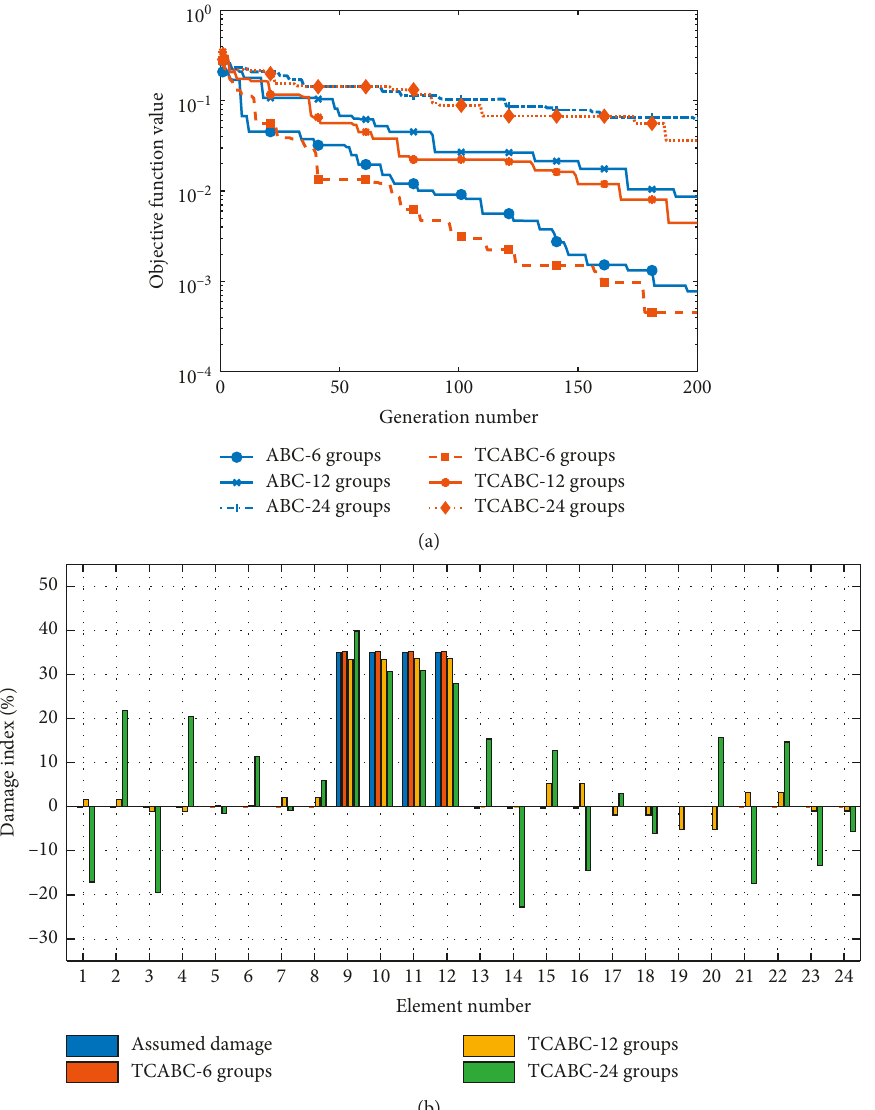
Figure 10: (a) The convergence performance under different sizes of grouping. (b) The identified parameters under different sizes of